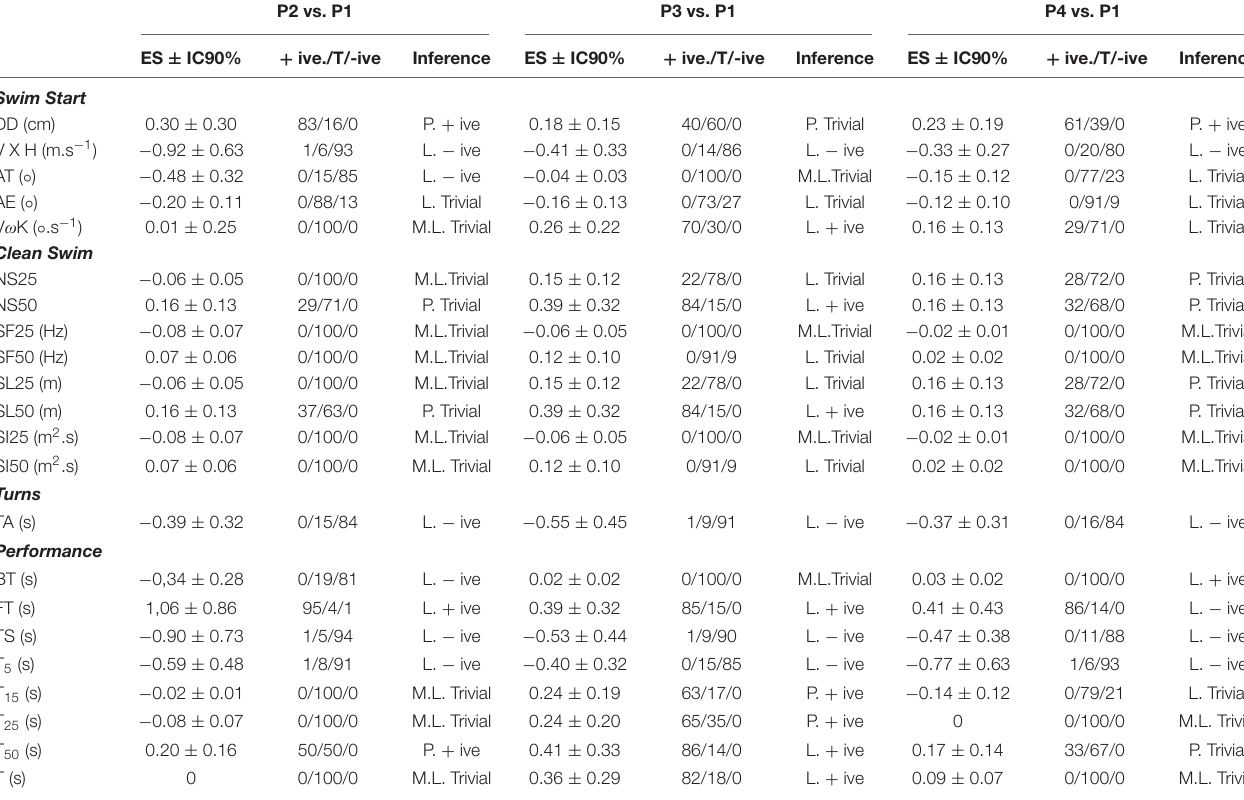
TABLE 3 | Magnitude of the differences between Protocol 1 and conditioning activity for kinematic variables observed at the swim start, clean swim, turns and performance in each protocol. P2 vs. P1 P3 vs. P1 P4 vs.